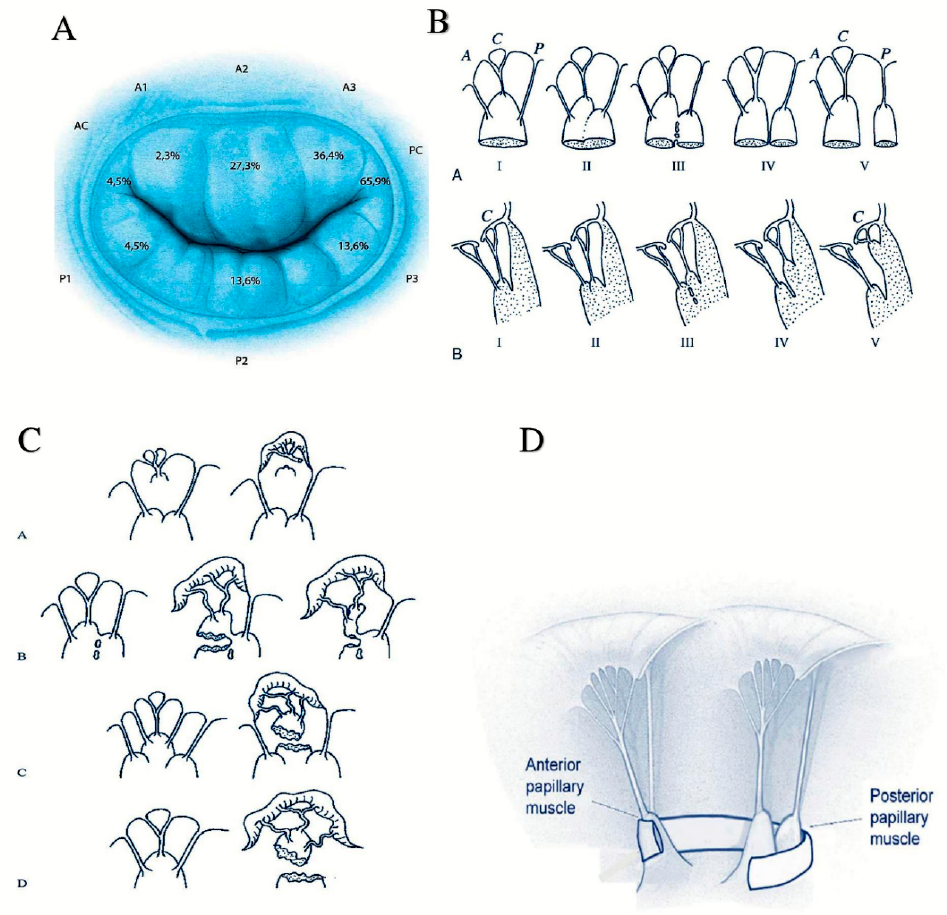
Figure 1. ( A ). Distribution and incidence of valve annular stress after ischemic mitral regurgitation IMR. Valvular region is organized in anterior and posterior leaflet. Each leaflet is divided in three segments or scallops that are named A1, A2, A3 and P1, P2, P3 relating to anterior or posterior cusp, respectively. The leaflets are attached to fibrous circular annulus and join in the anterior and posterior commissure, respectively, giving to the mitral valve the appearance of a curtain that is closed during systole. Tethering greatly affects the A3 and P3 segments and the posterior commissure (PC); ( B ) Segmentation and morphological types of papillary muscles; I, single uniform unit; II, groove with two apexes; III, fenestrations with muscular bridges; IV, complete separation in two adjacent heads; V, complete separation with two distant heads. Division can occur according to two directions: (A small) Division in a sagittal plane leading to a separate posterior leaflet head. (B small) Division in a coronal plane leading to a separate commissural head. A, anterior leaflet; C, commissure; P, posterior leaflet; ( C ) Mechanisms of ischemic mitral valve regurgitation for chordae stress and stretch with partial or total necrosis of papillary muscle approximation (PMA): (A small) Necrosis of a separate commissural head (inserted close to the annulus) with rupture of the anchorage of the commissural chord. (B small) Necrosis of a single head papillary muscle subdivided in multiple heads with partial rupture. (C small) Necrosis of a fenestrated papillary muscle with detachment of its main insertion: “incomplete” rupture. With time, incomplete rupture mimics papillary muscle elongation. (D small) Single papillary muscle with complete and total rupture; ( D ) Papillary muscle approximation surgery using 4 mm tube of expanded politetrafluoroethilene to encercle the body of papillary muscle(s) (PMs). Posterior papillary muscle is anatomically of type III-V.